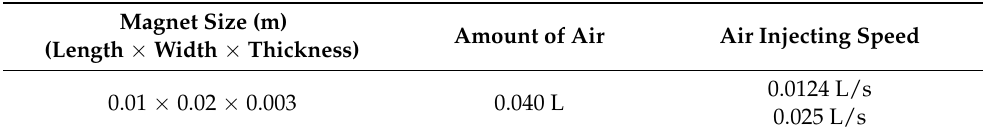
Table 6. Conditions for the robot used in the comparison of jump forces depending on the air injecting speed.